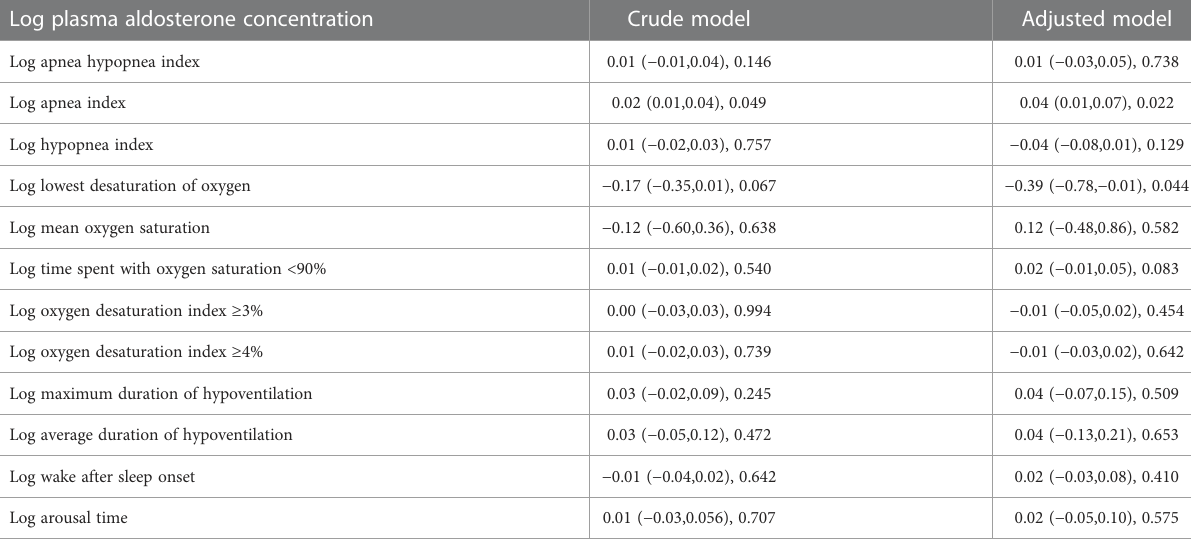
TABLE 3 Liner regression analysis for the relationship of log-transformed PSG-based sleep parameters with log-transformed plasma aldosterone concentration in men participants with hypertension without interfering agents (B, 95%CI, p). Log plasma aldosterone